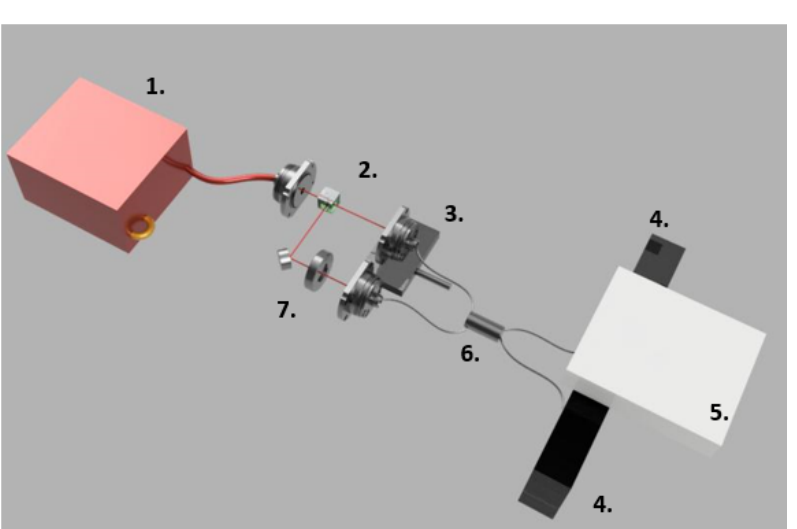
Figure 1. Scheme of the experimental setup employed to perform HoM interferometry in polarization. (1.) Twin photon source, (2.) polarizing beam splitter, (3.) linear translation stage, (4.) single photon avalanche diodes detectors (SPADs), (5.) time tagger, (6.) fiber coupled beam splitter and (7.) half- wave plate (HWP) mounted on motorized rotational stage. This figure is obtained via Fusion